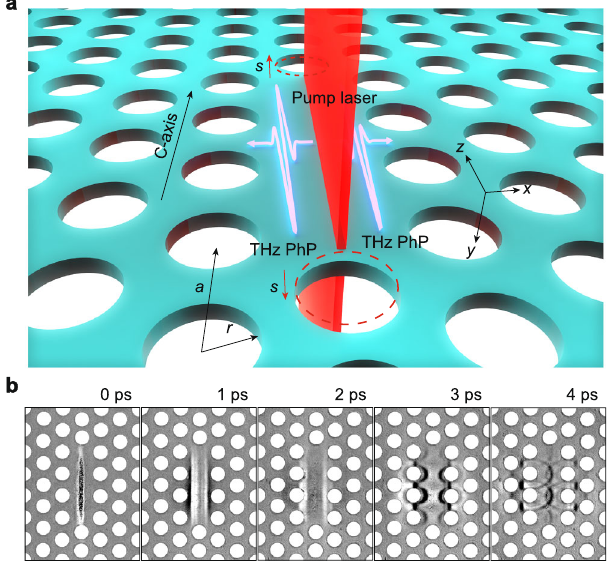
Fig. 3 Experimental design of the microcavity and measured temporal evolution of the THz phonon polaritons. a Illustration of the pump laser and layout of the microcavity. Parameters: a ¼ 170 μ m, r ¼ 50 μ m, s ¼ 0 : 15 r . b Temporal evolution of THz phonon polaritons in the microcavity. From left to right, are snapshots of the electric fi eld of the THz phonon polaritons in the sample from t = 0 ps to 4 ps upon